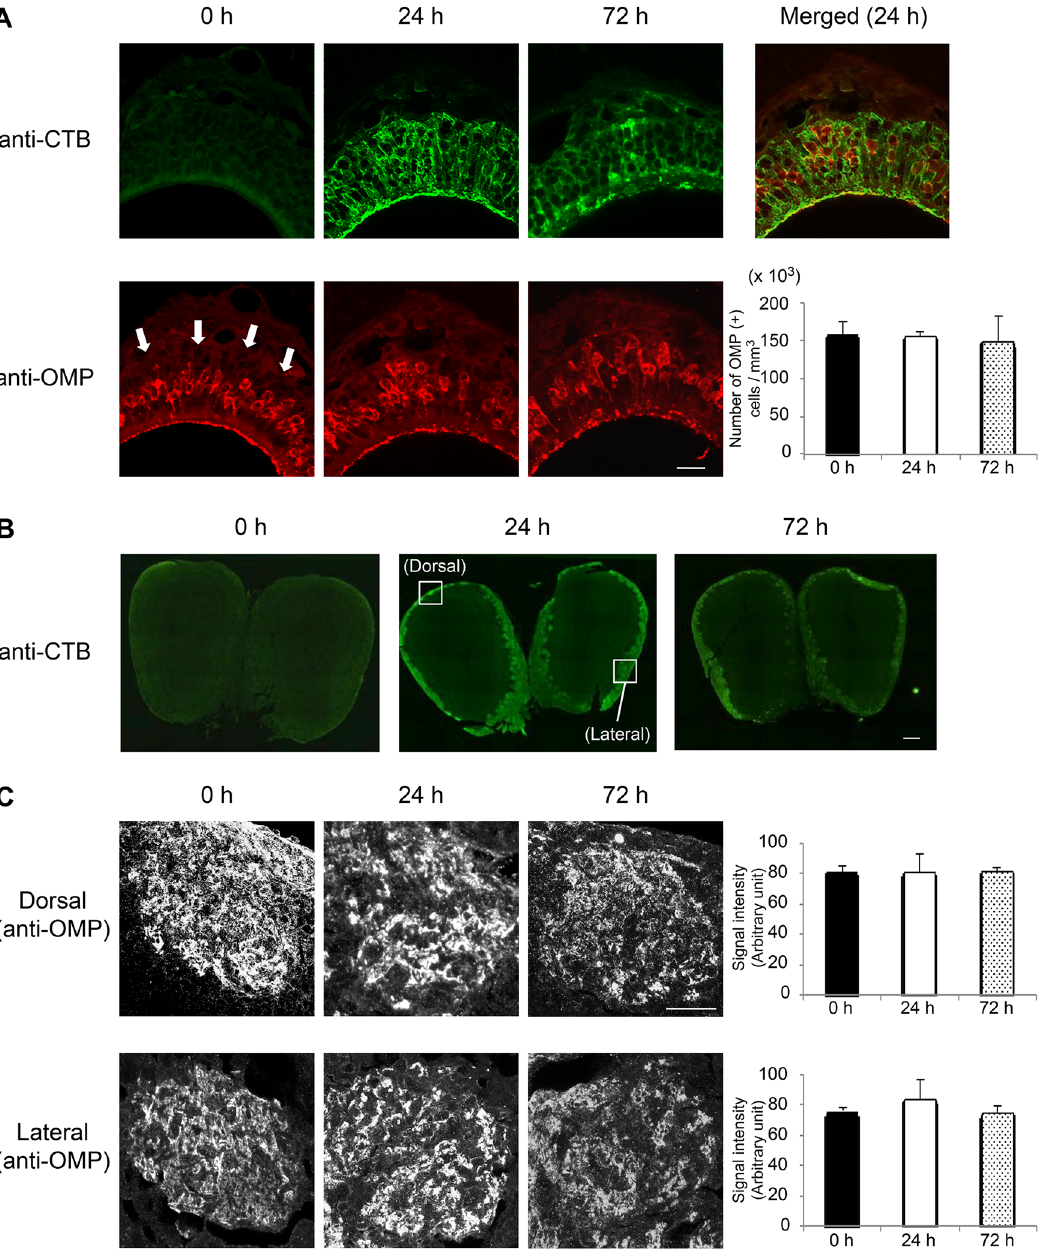
Fig 1. Immunohistochemical staining of the OE and OBs after nasal administrationof 30 μ g CTB. OE and OBs were obtained at 0 (untreated), 24, or 72 h after nasal administration of 30 μ g CTB. ( A ) Frozen sections of OE were stained with an anti-CTB Ab (green) or anti-OMP Ab (red). White arrows indicate the olfactory nerve layer. The number of OMP-positive cells (mean ± 1 SD; n = 3 mice) in each experimental group is shown at the right. ( B ) Frozen sections of OBs were stained with an anti-CTB Ab. ( C ) Frozen sections of OBs were stained with an anti-OMP Ab (converted to black and white images). Glomeruli at the dorsal and lateral surfaces of the OBs (indicated by the boxes in panel B) are shown. The signal intensity (mean ± 1 SD; n = 3 mice) in each experimental group is shown. Data are representative of three independent experiments. Scale bars: (A, C) 20 μ m, (B) 200 μ m.